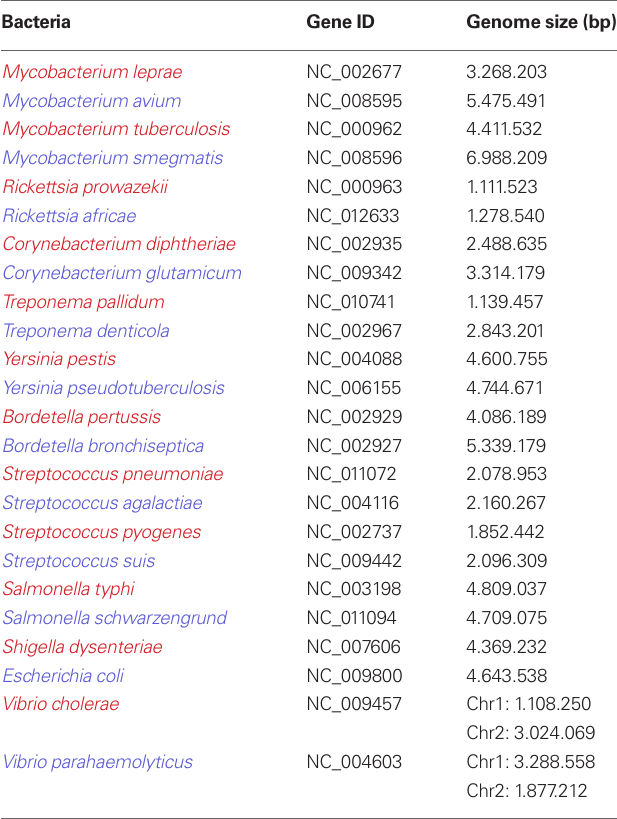
Table 1 | genome size of the 12 bigger bacterial epidemic killers of mankind, compared to their closest non-epidemic